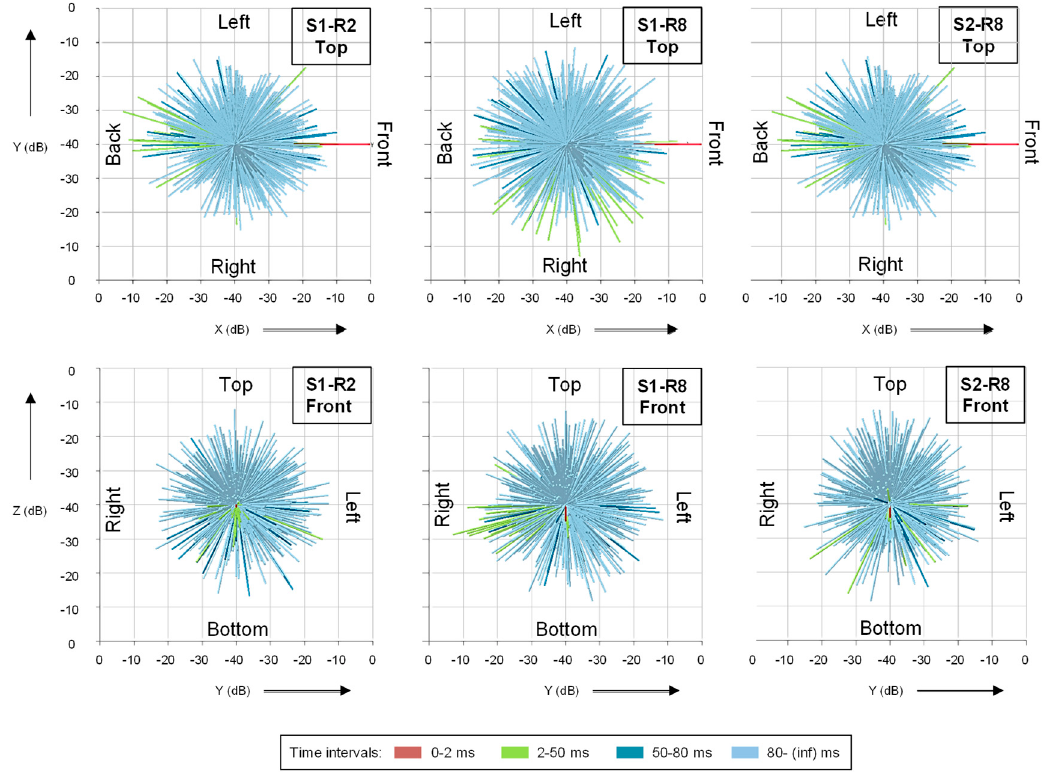
Figure 11. Representation of early and late energy arriving at selected S-R combinations (2D Iris plots, XY plane (upper row) and YZ plane (lower row), level range set to 40 dB with the direct sound level individually set as a reference (0 dB)).